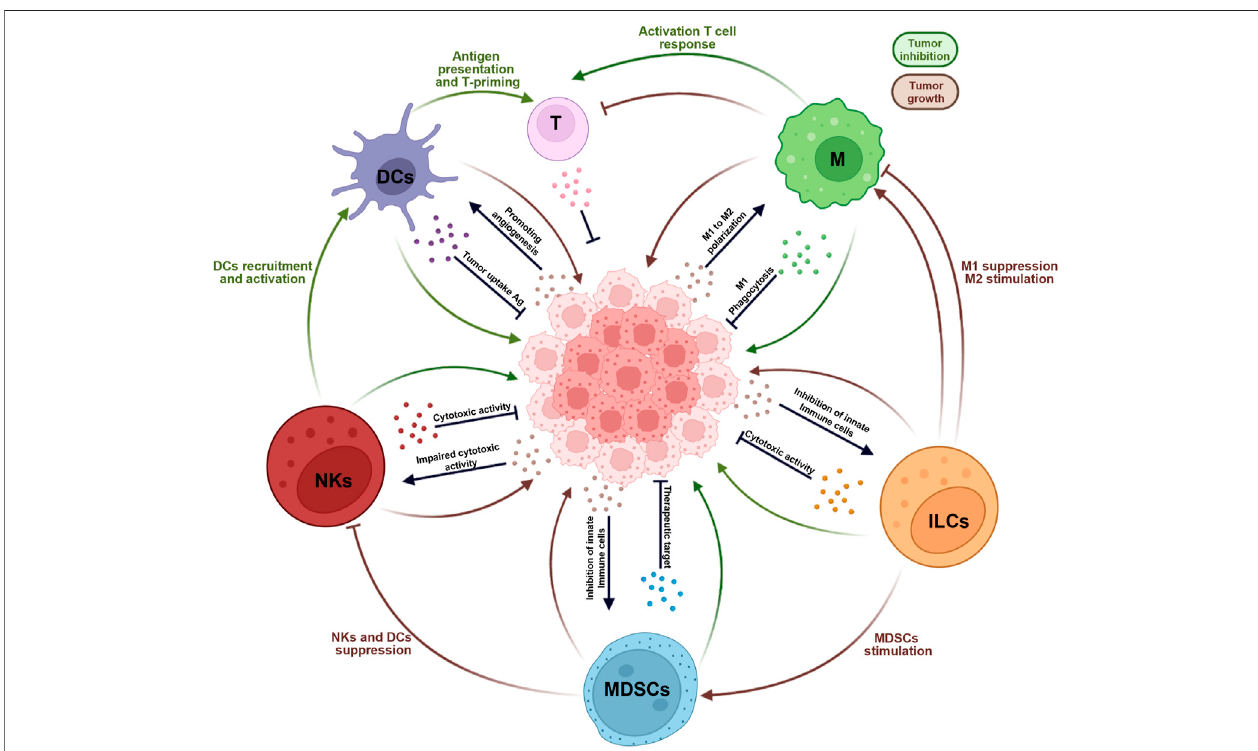
FIGURE 1 | Orchestration of cancer immune control. Within the tumor each tissue-resident innate immune cells exert both positive (tumor inhibition, in green) and negative (tumor growth, in brown) immune regulatory functions. The tissue-resident innate immune cells are important contributors in modulating the tumor microenvironment thoughthesecretion ofgrowth factors, chemokines,and cytokines. Asshowinthe fi gure,themainlysubpopulationinvolved aredendritic cells(DCs), macrophages, myeloid-derived suppressor cells (MDSCs), natural killer cells (NKs), and innate lymphoid cells (ILCs).